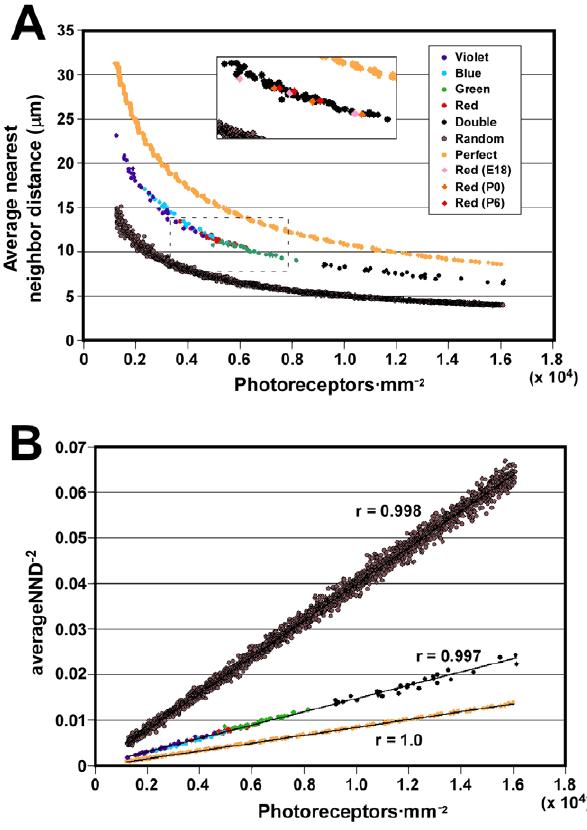
Figure 6. All cone types measure intercone distance with the same yardstick. (A) Graph of photoreceptor density vs. average nearest neighbor distance for all 140 P15 cone mosaics examined (middle curve). The upper and lower curves are graphs of density vs. average nearest neighbor distance for a series of computer-generated perfect and random distributions, respectively. The inset shows data for the three developmental timepoints (i.e., red cones at E18, P0 and P6). It corresponds to the region of the main graph highlighted with a dotted box except that all P15 chicken datapoints shown in the main graph are shown in black to facilitate visualization of the developmental timepoints. (B) Graph of the same datapoints as in (A) but shown as density vs. the inverse-square of the average nearest neighbor distance. The linear correlation coefficients (r) for the best fit line for each of the three datasets are